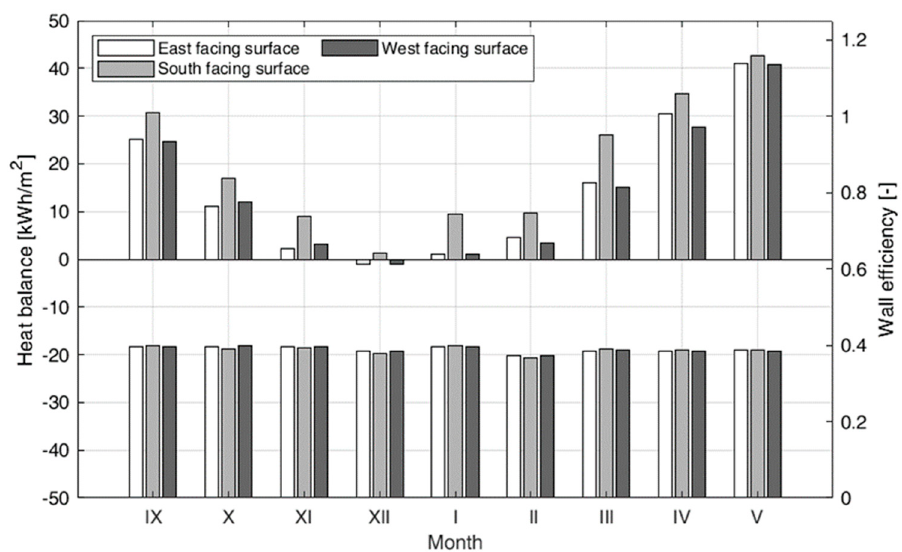
Figure 13. Comparison of monthly thermal balances (top) and thermal efficiency (bottom) of the SW-TI with the insulation thickness of 108 mm in the case of different orientations (location in Pozna ń ).